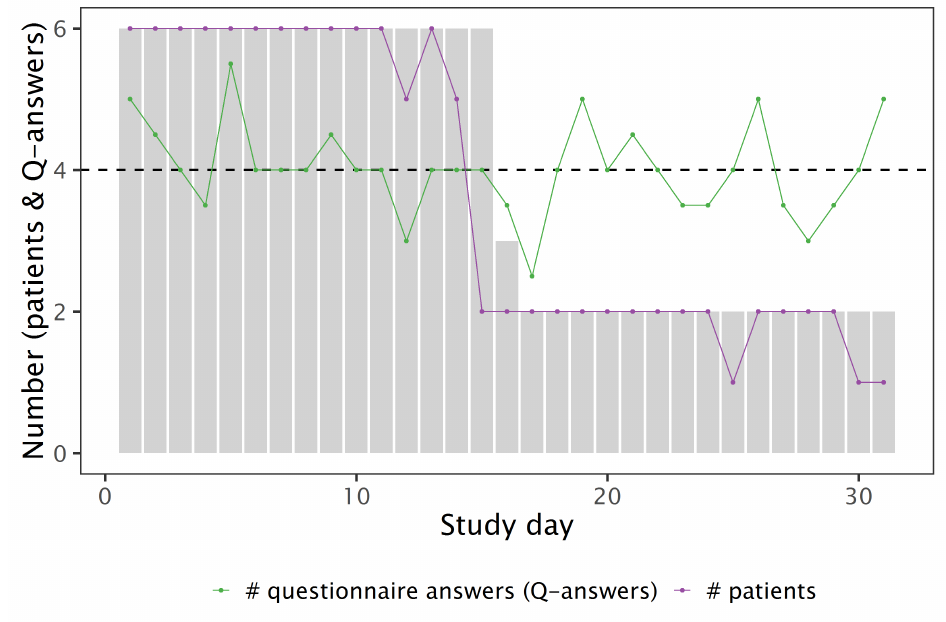
Figure 4. Average answering rate of the six included patients. The bars denote the number of participating patients, the violet line represents the number of patients that have answered at least once the questionnaires and the green line denotes the median number of questionnaires that were answered by these patients at a day. The dashed line denotes the requested number of four questionnaires per day.